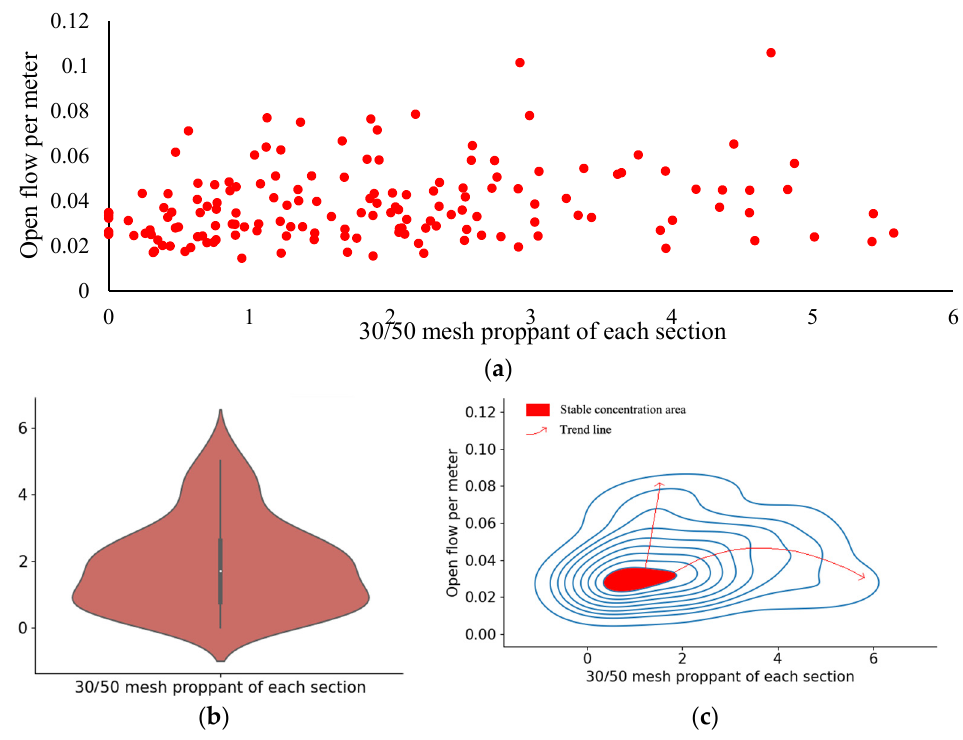
( c ) Figure 8. Analysis of 40/70 mesh proppant data. ( a ) Scatter plot of 40/70 mesh proppant; ( b ) violin plot of 40/70 mesh proppant; ( c ) binary KDE plot of 40/70 mesh proppant. 4.3.6. Proppant of 30/50 Mesh in Each Section The scatter, violin, and binary KDE diagrams of 30/50 mesh proppant in each section are drawn as shown in Figure 9a–c, respectively. Figure 9a shows that the distribution of 30/50 mesh proppant in each section of the high-yield well is average and very scattered. In Figure 9b, the median value in each section is 1.8 m 3 , the 95% data confidence interval is distributed between 0 and 5 m 3 , and the high yield is concentrated between 0.5 and 2.2 m 3 . In Figure 9c, the stable concentration area of 30/50 mesh proppant in each section of